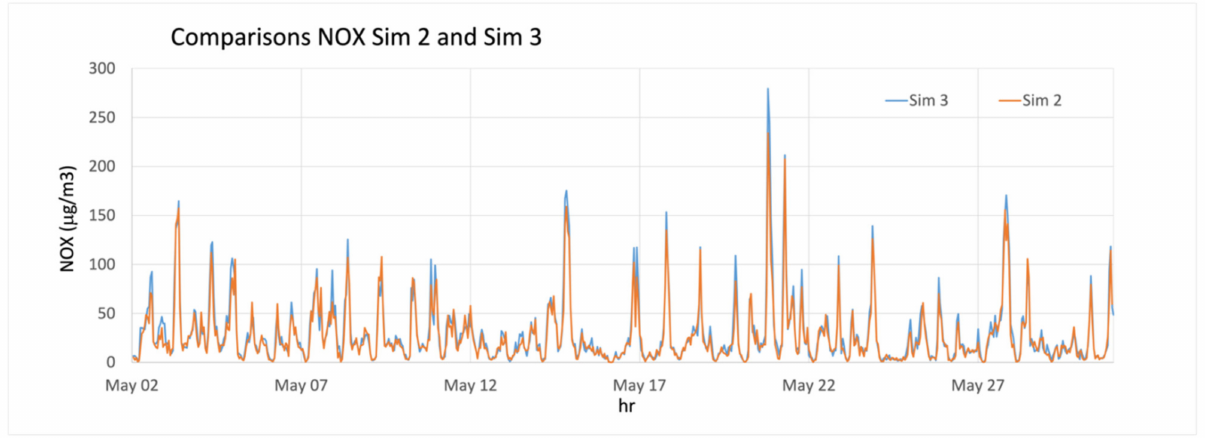
Figure 13. Comparison between Sim 2 and Sim 3 at Magna Grecia in terms of the concentration timeseries.